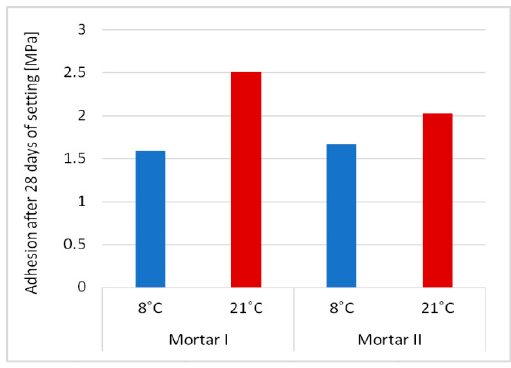
Figure 8. Di ff erences in adhesion of PCC mortars curing in two temperatures: 8 ◦ C and 21 ◦ Figure 8. Differences in adhesion of PCC mortars curing in two temperatures: 8 °C and 21 °C.